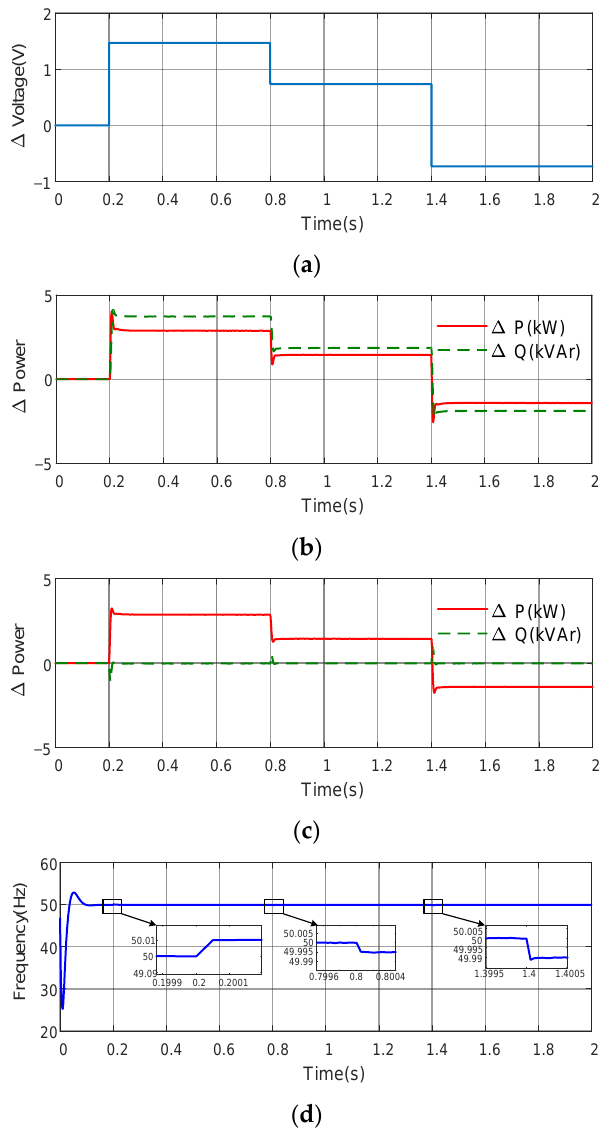
Figure 10. Active power and reactive power responses of converter voltage, with and without feedforward control. ( a ) Voltage control values for the converter; ( b ) the active and reactive power changing values without feedforward control; ( c ) the active and reactive power changing values with feedforward control; ( d ) the converter output frequency.